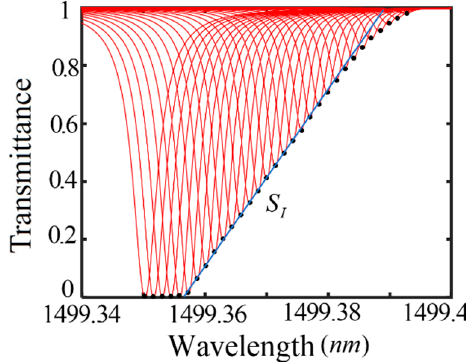
Figure A1. For the designed SIMRR sensor in Figure 1a, at SNR = 45 dB, the simulated transmission spectra near 1500 nm when only l is changed from − 15 nm (far left) to 0 nm (far right) with the step size of 0.5 nm. The single mode dissipative sensing is realized by measuring the variations in the depth of the transmittance dip near 1500 nm. The largest sensitivity often occurs at the normalized transmission depth close to 0.5, and it is the slope of the line marked in the figure.